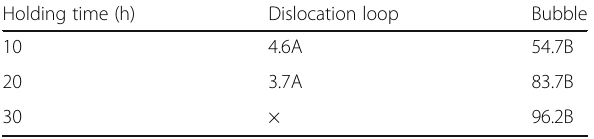
Table 3 The evaluation of irradiation hardening of V-4Cr-4Ti alloy that underwent the post-irradiation annealing treatment for 10, 20, and 30 h at 450 °C Holding time